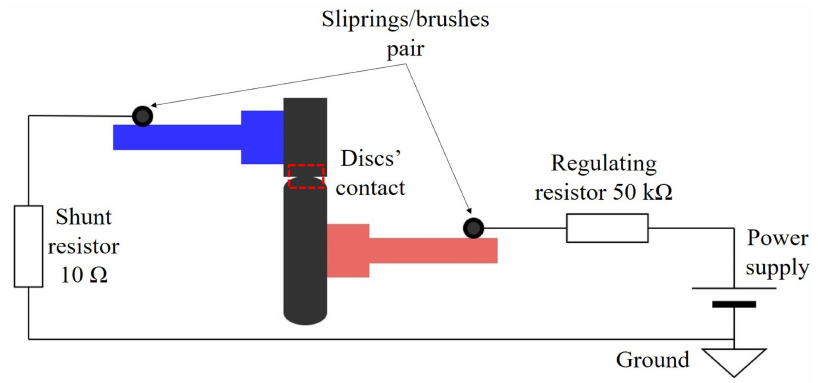
Figure 3. A schematic of the electrical circuit in the TE74 test rig.